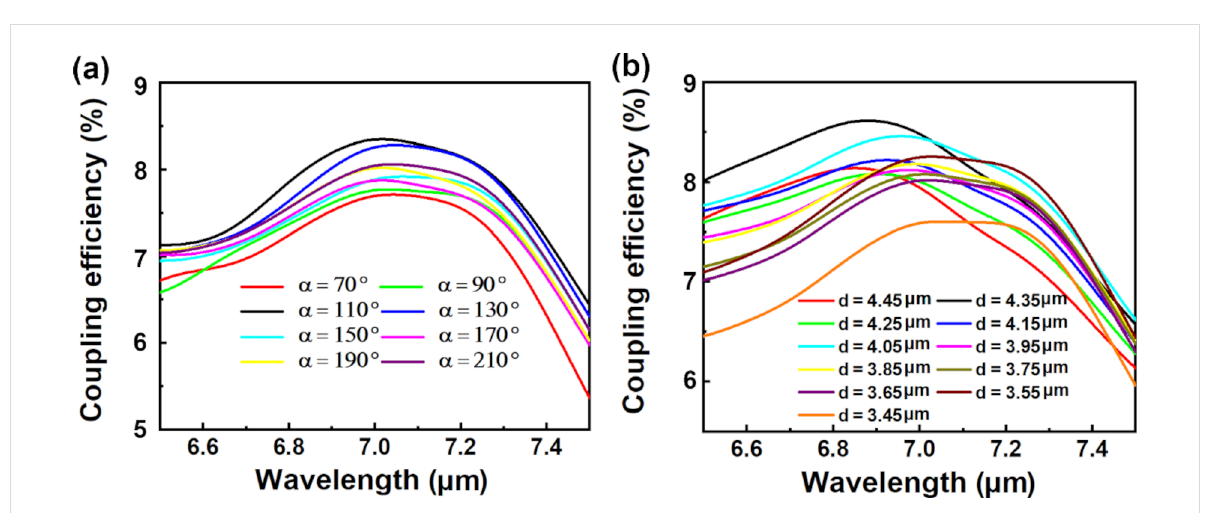
Figure 4: Coupling efficiency of the proposed MIR FGC at different (a) opening angle ( d = 3.55 μ m) and (b) location ( α = 120°) with θ = 15°, R = 7.15 μ m, and r = 6.15 μ m.